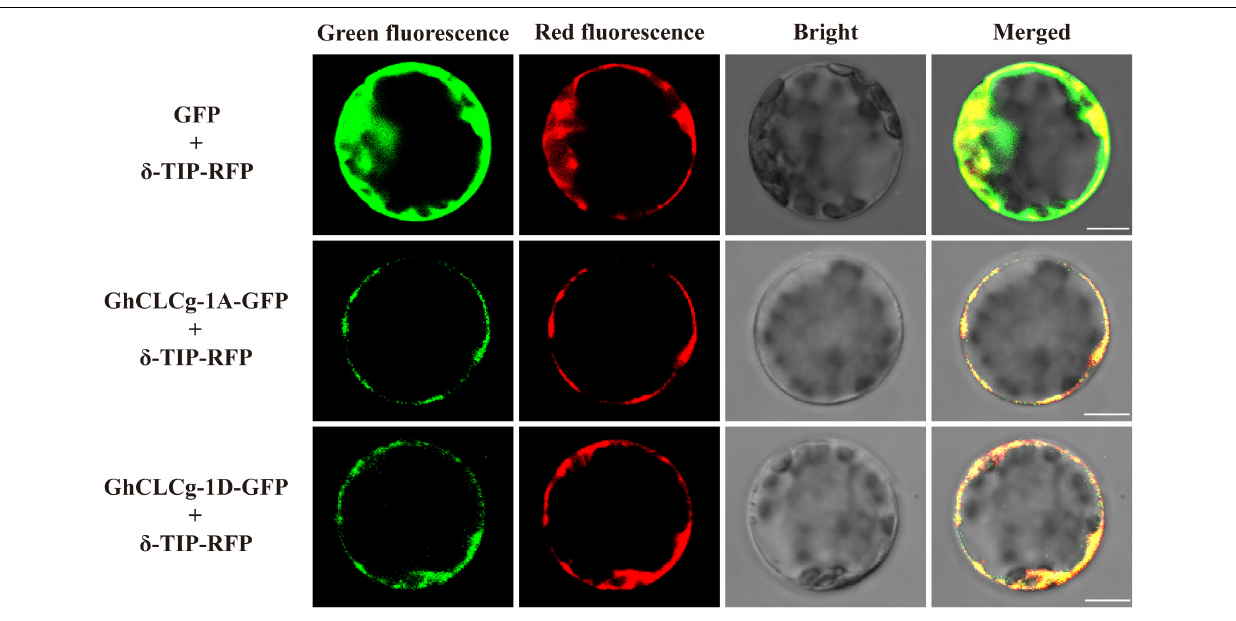
FIGURE 3 | Subcellular localization of GhCLCg-1A/D. GhCLCg-1A-GFP, and GhCLCg-1D-GFP were co-expressed with the vacuolar marker protein δ -TIP-red fluorescent protein (RFP) in leaf protoplasts of Arabidopsis thaliana seedlings. Green fluorescent protein (GFP) co-transformed with δ -TIP-RFP as positive control. Scale bar = 10 µ